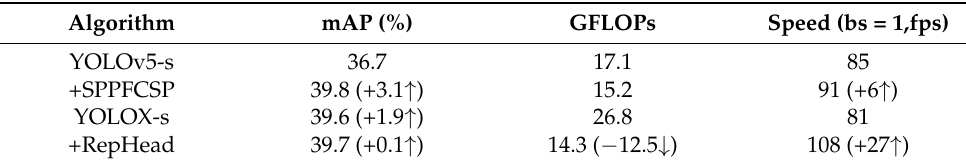
Table 2. Ablation studies on the COCO2017